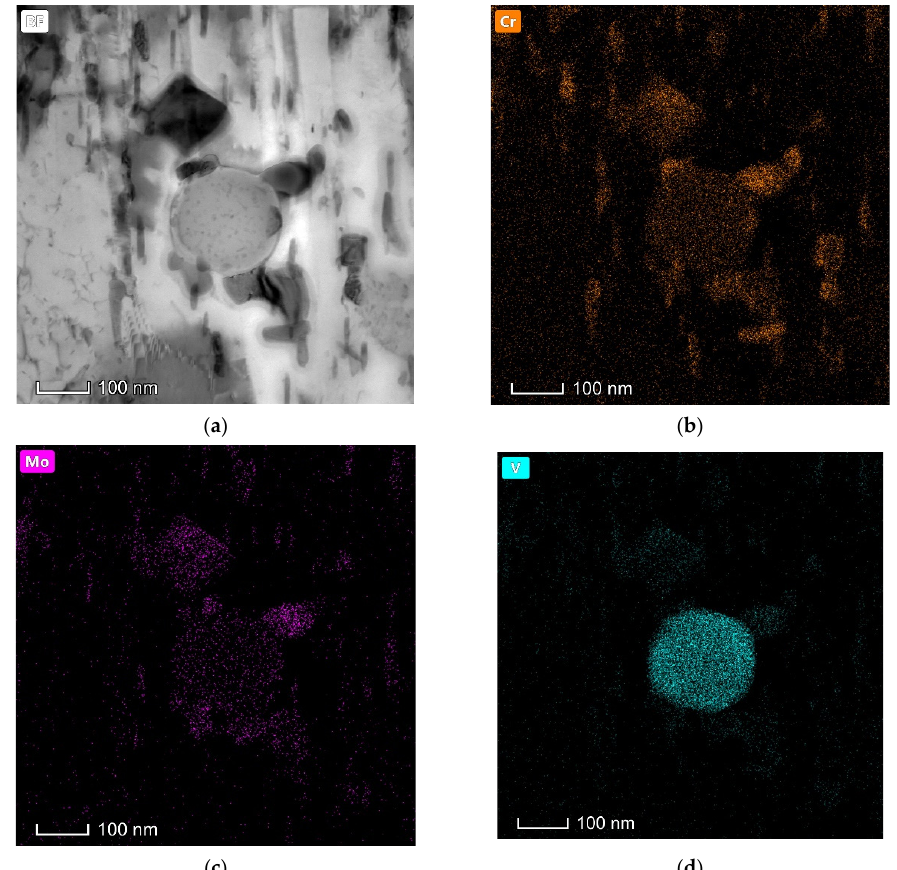
Figure 7. STEM EDS ‐ mapping on different carbides precipitated upon tempering Dievar steel for 24 h: ( a ) The bright field image showing the existence of spherical, faceted, and rod ‐ shaped carbides; ( b – d ) Elemental mapping.